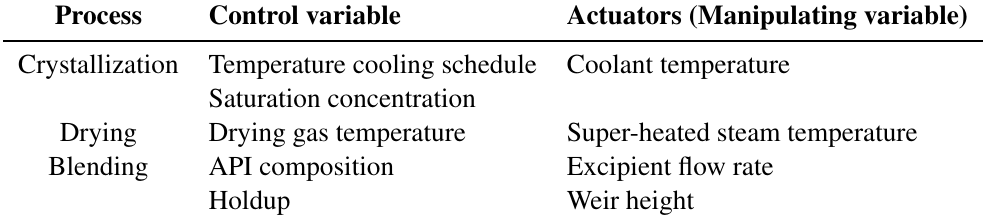
Table 1. List of control and manipulated variables for each unit operation. API, active pharmaceutical